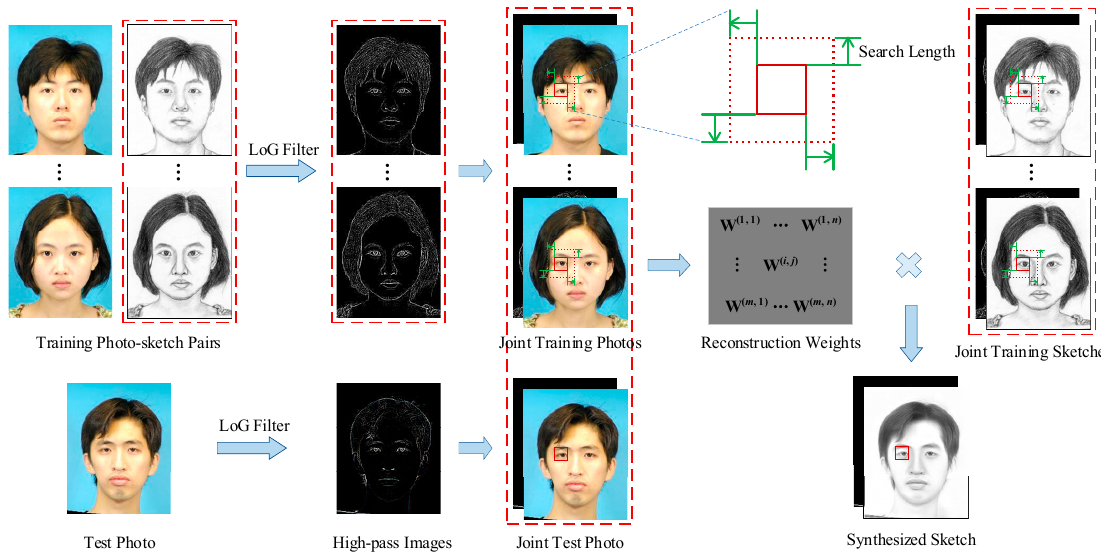
Figure 1. Illustration of the proposed joint model for face sketch synthesis.